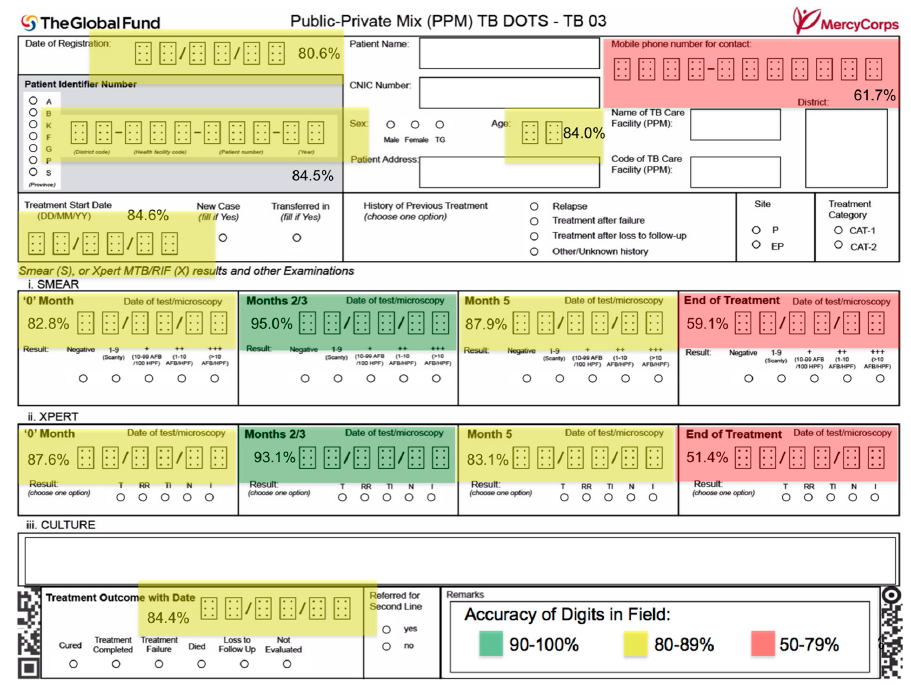
Figure 4. Mapping of the accuracy measures of the number boxes.